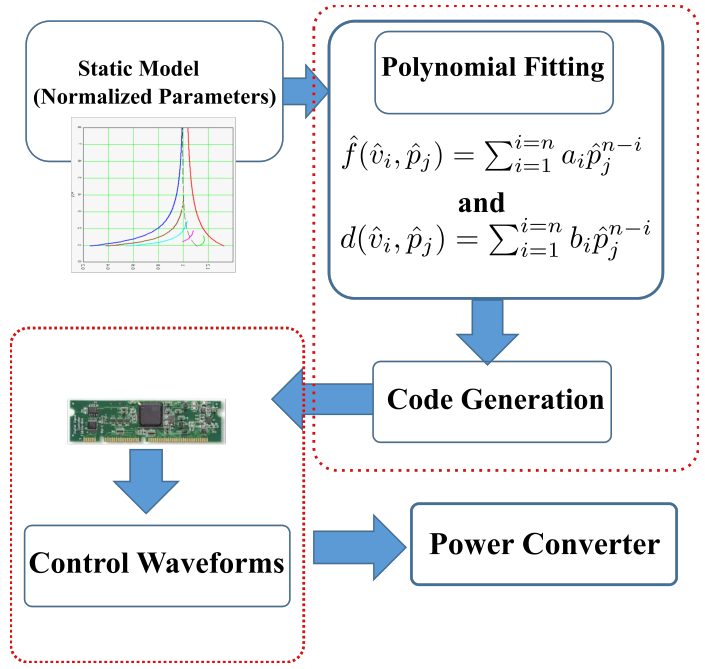
Figure 3. Illustration of the various stages of the